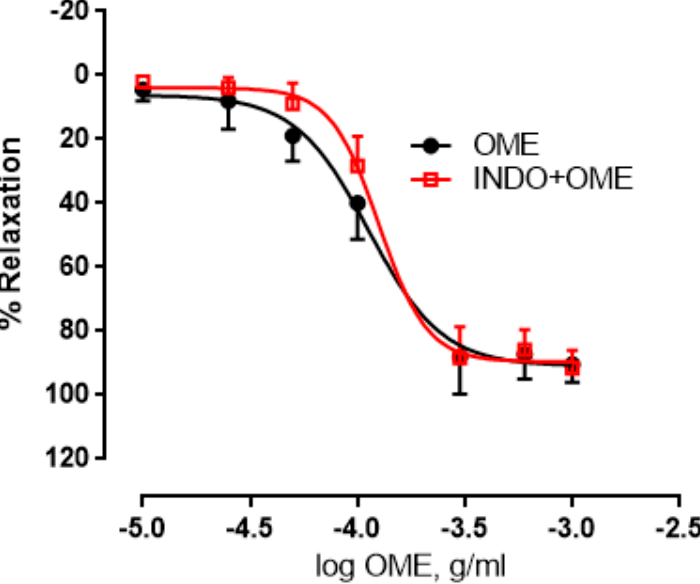
Figure 9. Effect of cyclooxygenase inhibition by indomethacin on OME-induced aortic relaxation. Rings with intact endothelium were pre-treated without (OME; black) or with indomethacin (a cyclooxygenase (COX)1/2 inhibitor, 10 µM; INDO + OME; red) followed by the addition of cumulative doses of OME. Data showed represent mean ± SEM ( n = 5; p > 0.05).